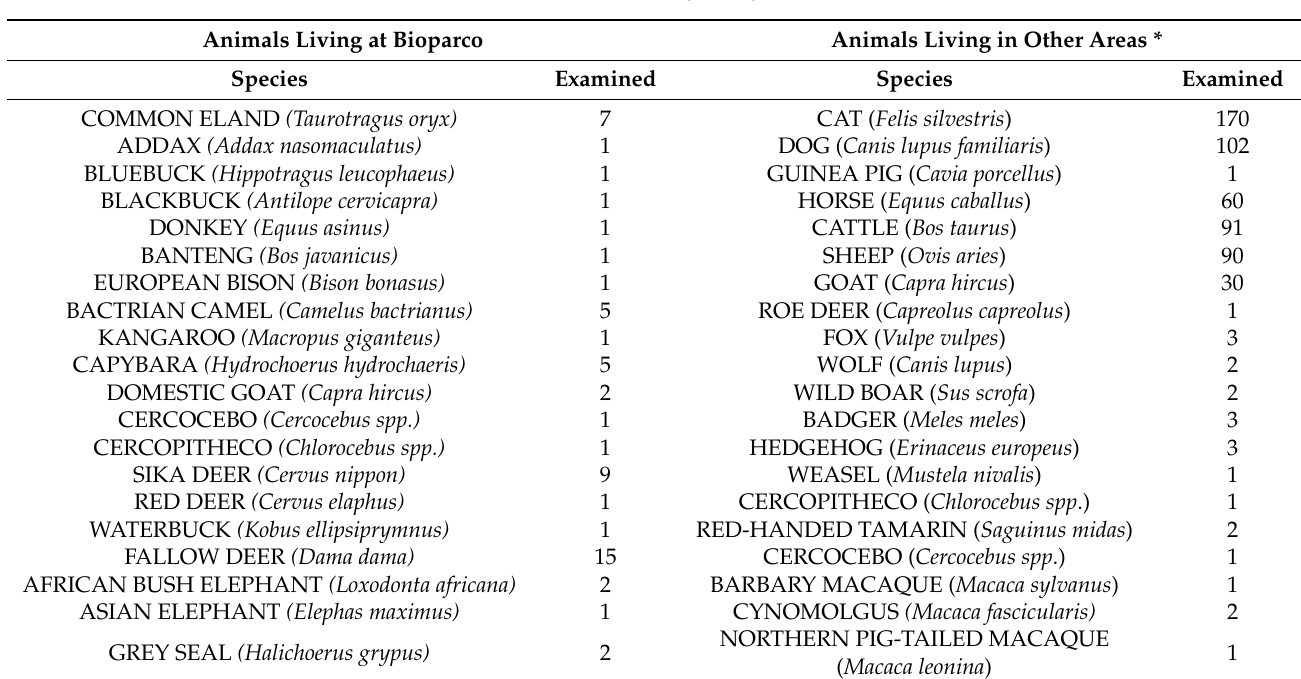
Table 5. Sera analysed by